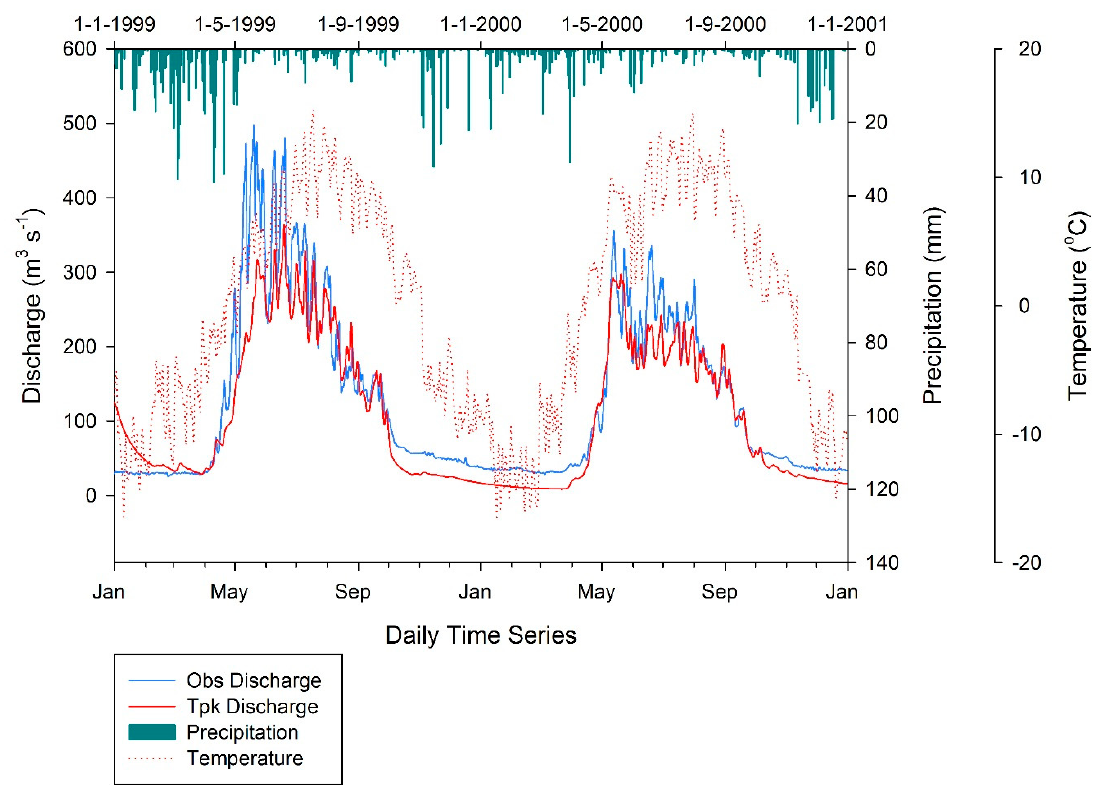
Figure 6. Comparison of simulated and observed discharge at Doiyan (Astore River Basin outlet) along with temperature and precipitation, during the calibration period 1999–2000.